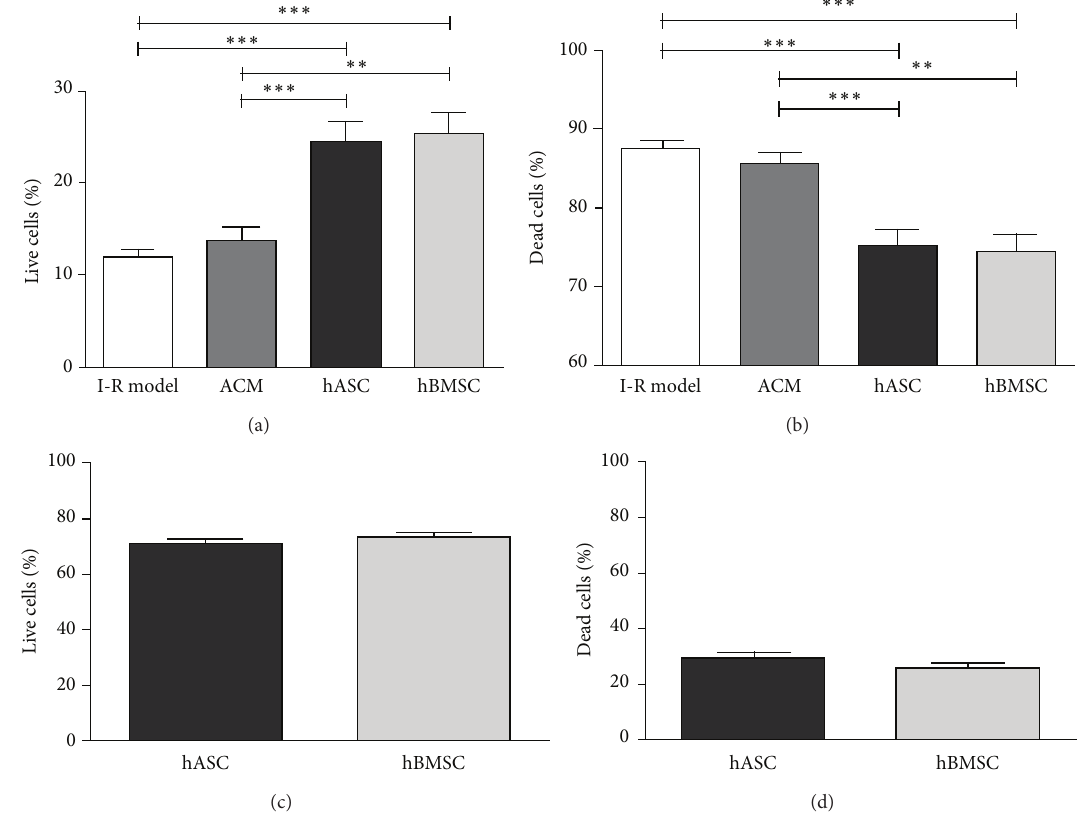
Figure 3: Flow cytometric analysis of the postischemic cells and the therapeutic cells after 24 hours. Flow cytometric cell death analysis of the postischemic cells revealed that cell treatment increased the percentage of live cells (a), while ACM did not (I-R model: 12.13 ± 0.75 %; ACM: 13.94 ± 1.44 %; hASC: 24.66 ± 2.49 %; hBMSC: 25.41 ± 1.99 %). (b) The percentage of dead cells decreased when therapeutic cells were added (I-R model: 87.71 ± 0.82 %; ACM: 85.75 ± 1.57 %; hASC: 75.24 ± 2.49 %; hBMSC: 74.62 ± 1.99 %). The percentages of live (c) and dead (d) cells among the therapeutically added cells were not significantly different ( 𝑛 = 17–31, ∗∗ 𝑃 < 0.01 , ∗∗∗ 𝑃 < 0.001 ).